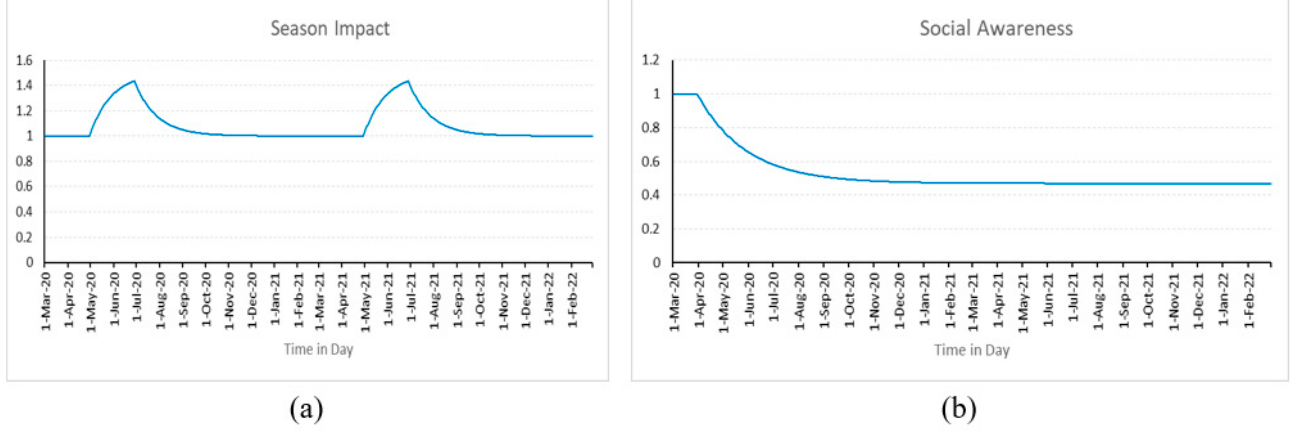
Figure 3. Behavior of ( a ) Seasonal impact; ( b ) Social awareness.